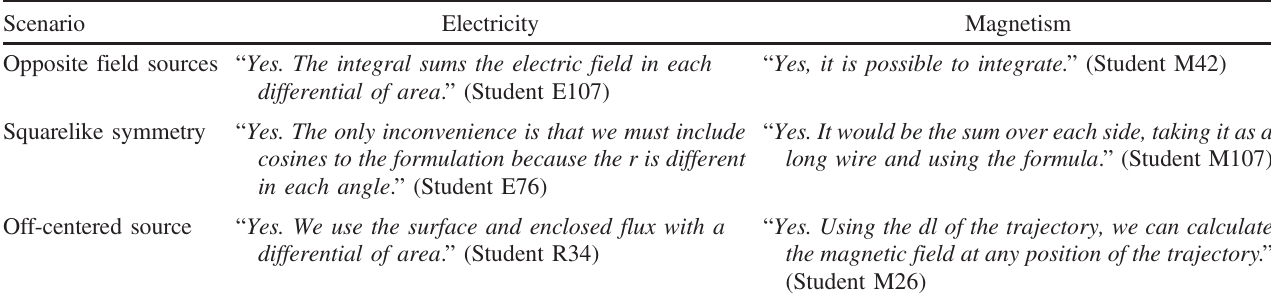
TABLE VII. Examples of students ’ reasoning in the category difficult solution for each scenario.